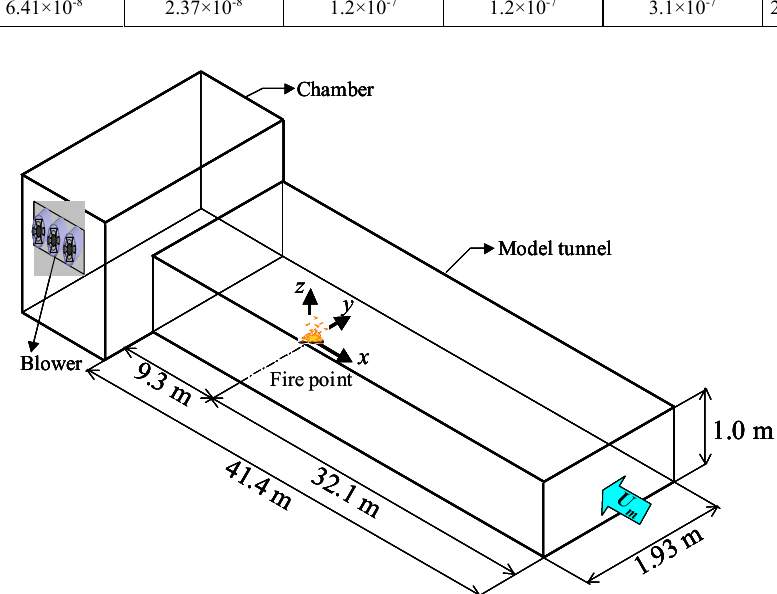
Fig. 1 Schematic diagram of the experimental